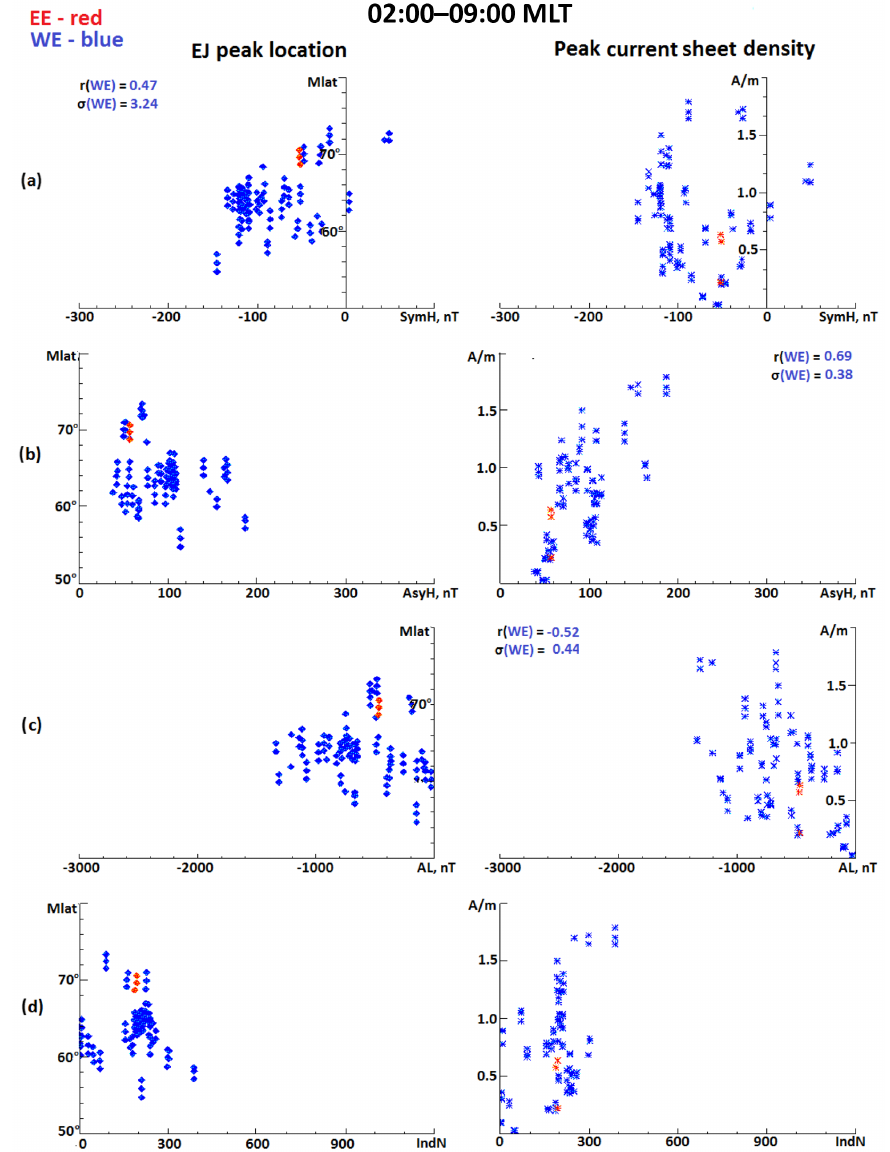
Figure 7. The same as in Fig. 4, but for the morning sector